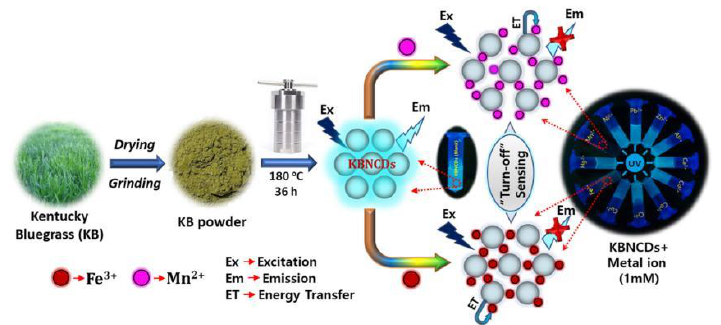
Figure 2. Schematic representation of the preparation process of KBNCDs and a possible quenching mechanism. Adapted with permission from Krishnaiah et al., 2019, copyright 2019. Reproduced with permission from Elsevier [29].